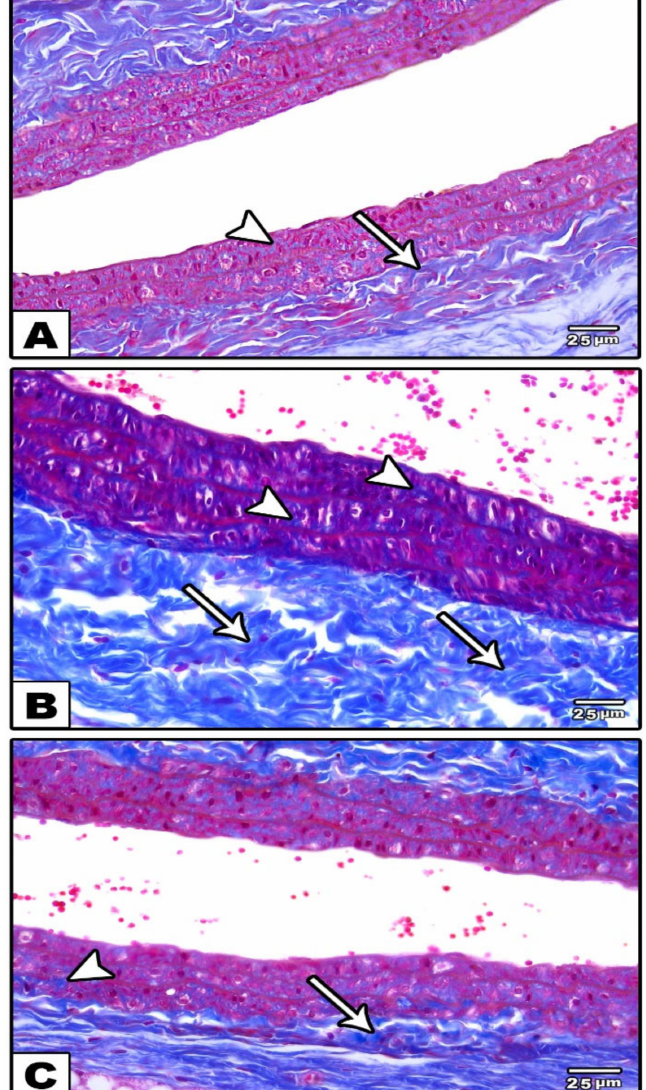
Figure 2. Photomicrographs of sections in the carotid artery stained with Masson’s trichrome stain. ( A ): In the control groups, minimal collagen fibers in tunica media (arrow) and in the tunica adventitia (arrowhead) are observed. ( B ): In the reserpine-treated group, a massive deposition of collagen fibers in tunica media (arrows) and in the tunica adventitia (arrowheads) is observed. ( C ): In the fisetin-treated group, moderate amounts of collagen fibers in tunica media (arrow) and in the tunica adventitia are